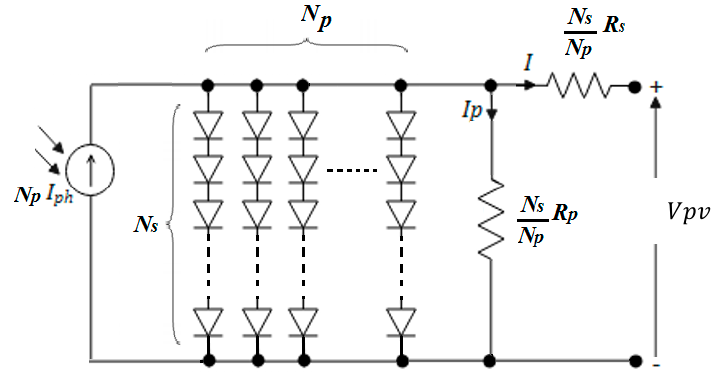
Figure 3. A general model of a Photovoltaic Module.